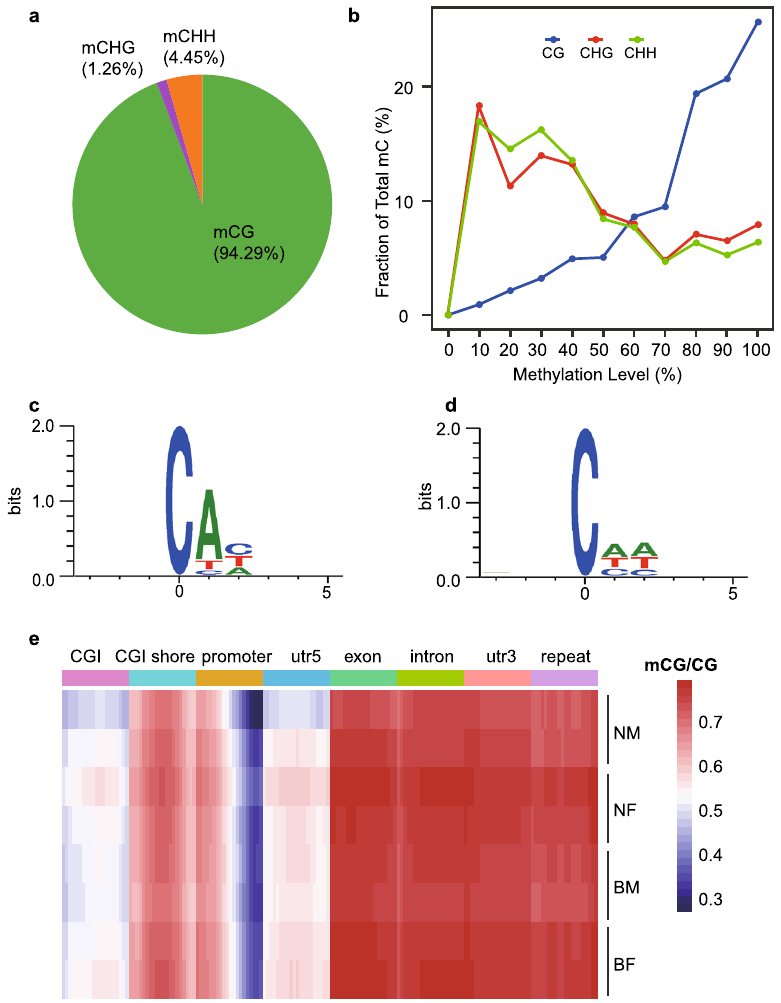
Figure 2. Methylation characteristics of CG, CHG and CHH contexts. ( a ) Proportions of methylated C sites in CG, CHG and CHH contexts. ( b ) Fractions of methylation levels in CG, CHG and CHH contexts, respectively. (c) Methylation motif in CHG context. (d) Methylation motif in CHH context. (e) Methylation ratios of the whole CG context in CGI, CGI shore, promoter, utr5, exon, intron, utr3 and repeat regions for normal muscle (BM), normal adipose (BF), muscle induced by WEA (NM) and adipose induced by WEA (NF)